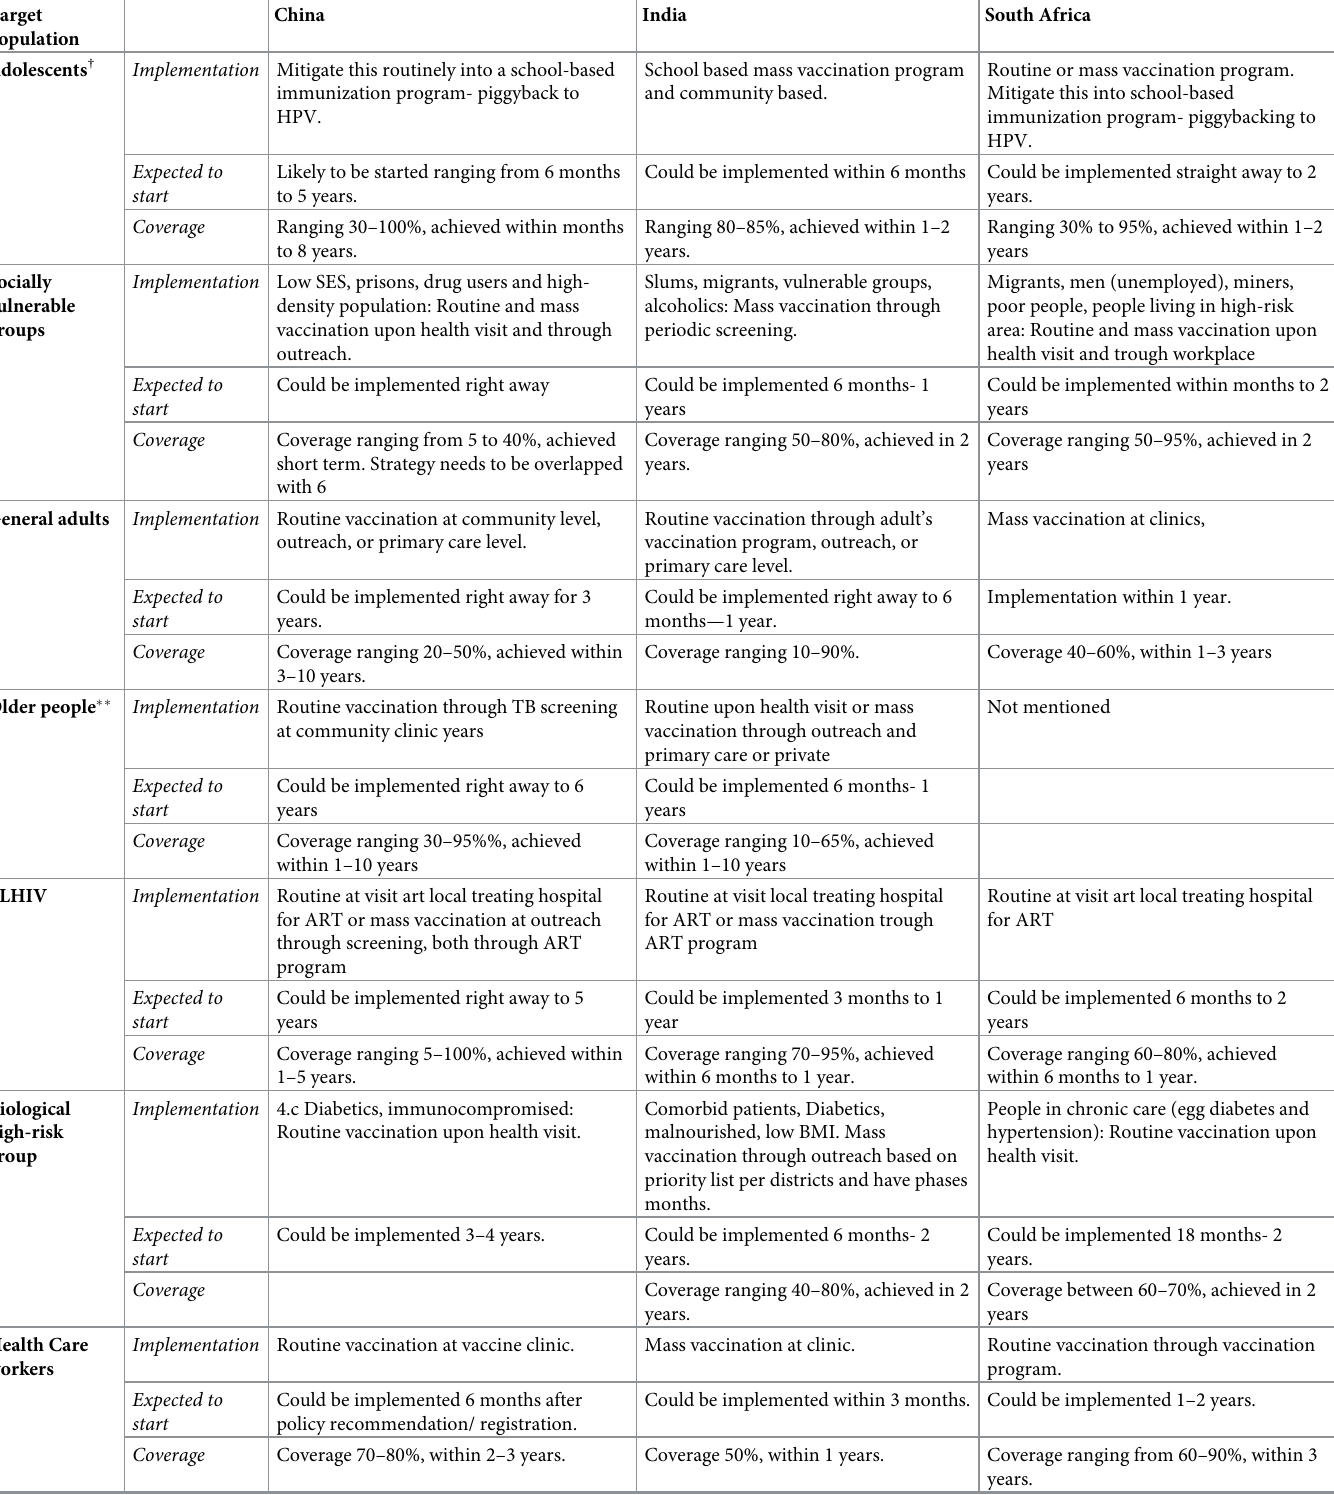
Table 2. Strategies to reach adult and adolescent populations with an M72/AS01 E -like candidate. Target